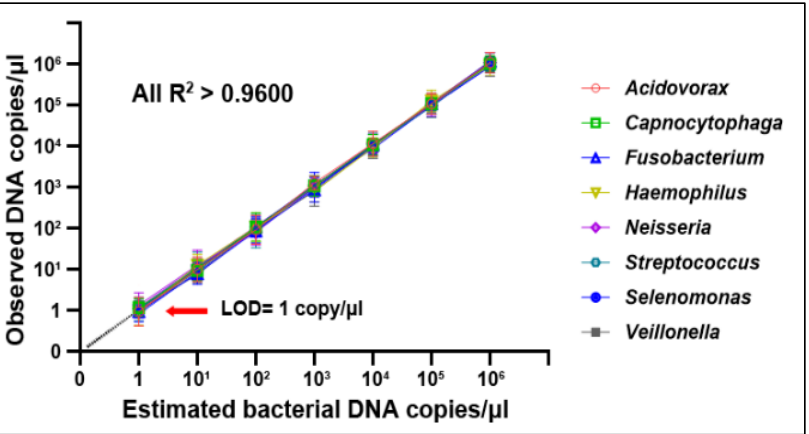
Figure 2. The dynamic ranges and sensitivities of ddPCR for detection of bacterial genera in serially diluted DNA standard samples. The x -axis represents concentrations of the dilution series, whereas y -axis represents measured concentrations of bacterial genera detected by ddPCR in triplets.